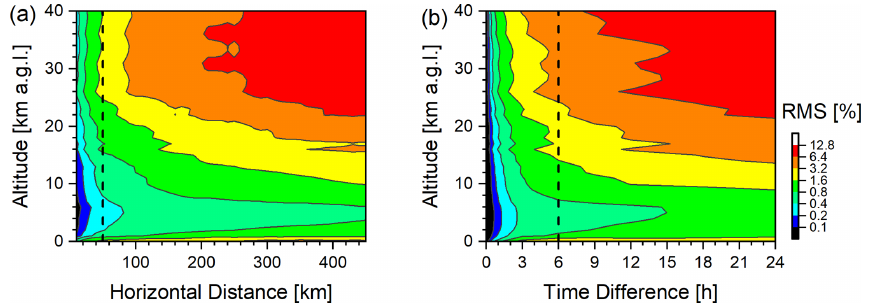
Figure E1. Square root values of the diagonal entries of different dislocation covariance matrices ( S l square (rms) of the difference between the reference methane profile (CAMS forecast for location 49.1 ◦ N, 8.4 ◦ E, corresponding to the location of Karlsruhe) and other forecasted profiles dislocated with respect to the reference: (a) horizontal dislocations and (b) temporal dislocations. The dashed black lines indicate the collocation threshold values used for valid combinations of IASI and TROPOMI.